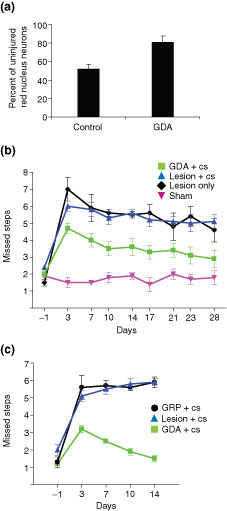
GDA transplantation suppresses atrophy of red nucleus neurons and promotes robust behavioral recovery. (a) Injured left-side red nuclei in control rats contained an average of 52% of the neurons counted in uninjured right-side red nuclei at 5 weeks after injury. The numbers of neurons in the injured left-side red nuclei of GDA-transplanted animals, however, was 81% of total neuron numbers in uninjured right-side nuclei (*p < 0.01). (b) Grid-walk analysis of locomotor recovery. Graph showing the average number of mistakes per experimental group at different time points after injury for GDA-transplanted rats versus the control-lesion and sham-operated groups. GDA-transplanted animals (green) performed significantly better than lesioned controls at all post-injury time points (p < 0.05). (c) Transplanted GRPs do not promote locomotor recovery. Graph showing the average number of grid-walk mistakes per experimental group from 1 day before injury (baseline pre-lesion) to 2 weeks after injury for a separate series of matched RST-lesioned rats that received either GRP or GDA transplants versus lesion-only control rats. Note the complete failure of locomotor recovery in GRP-transplanted animals compared with lesion-only controls at all time points and confirmation of significant locomotor recovery in response to GDA transplantation (p < 0.05). cs, cyclosporine.